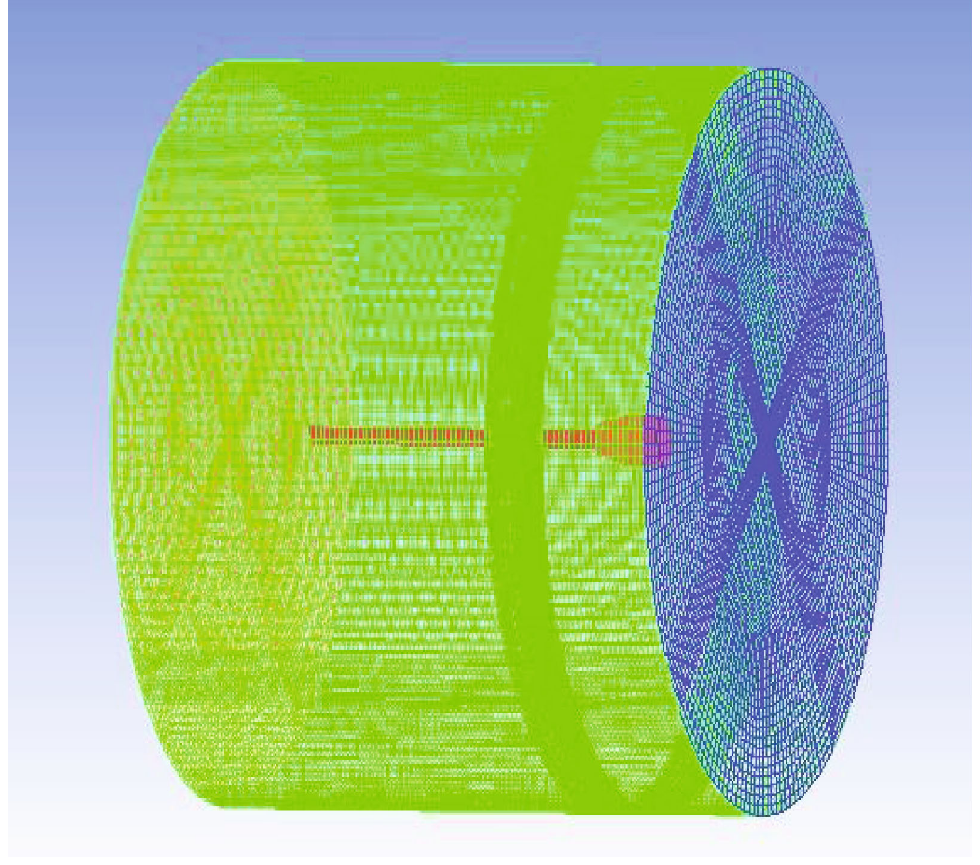
Figure 7: The three-dimensional computation grid of out fl ow fi eld of the submunition.